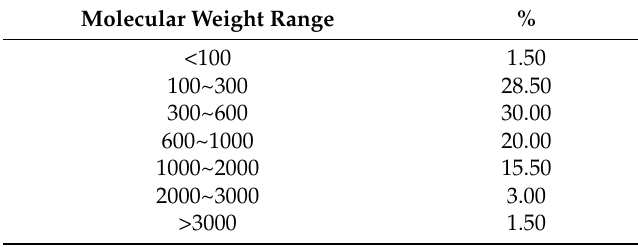
Table 1. Molecular weight distribution of Sea Cucumber Polypeptides (SCP).